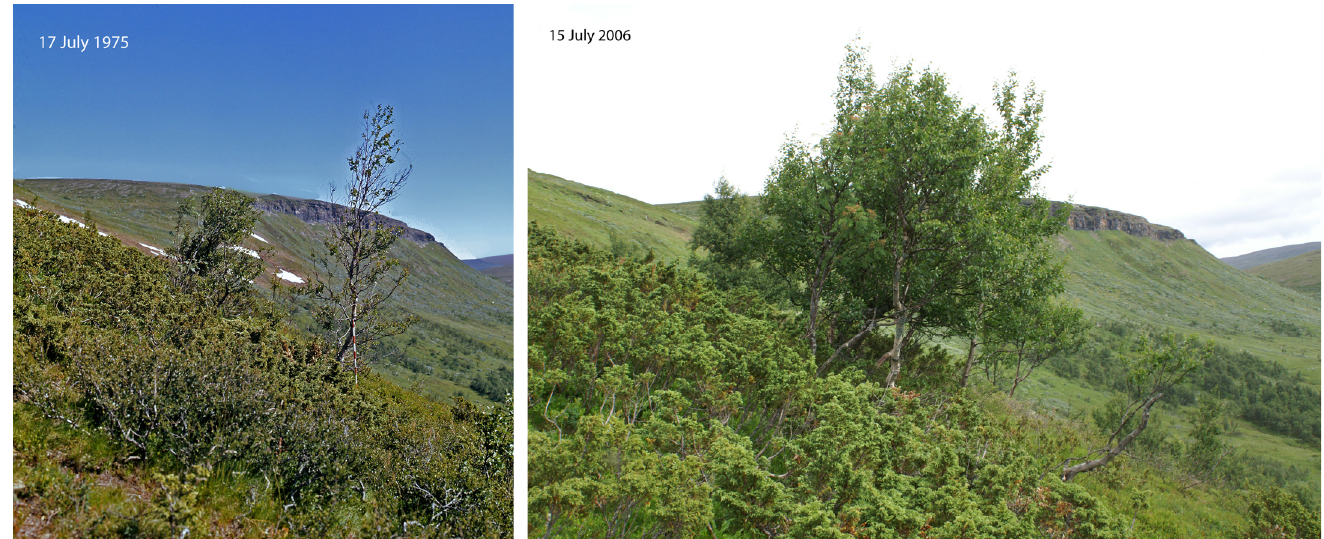
Figure 9. Characteristically, in areas with relatively more oceanic climate, the canopy of most treeline birches has increased in size and density since the mid-1970s. Mt. Hamrafjället, 985 m a.s.l..